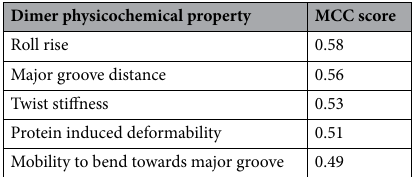
Table 3. Five fold cross validation MCC score for the top 5